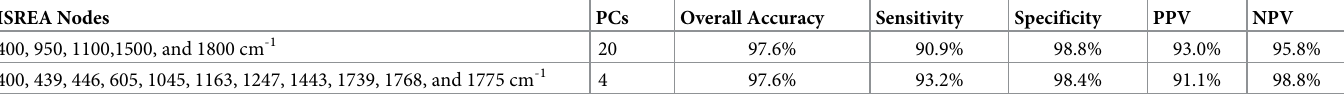
Table 2. Detection of COVID-19 in urine by Rametrix 1 given two different ISREA node sets. ISREA Nodes PCs Overall Accuracy Sensitivity Specificity